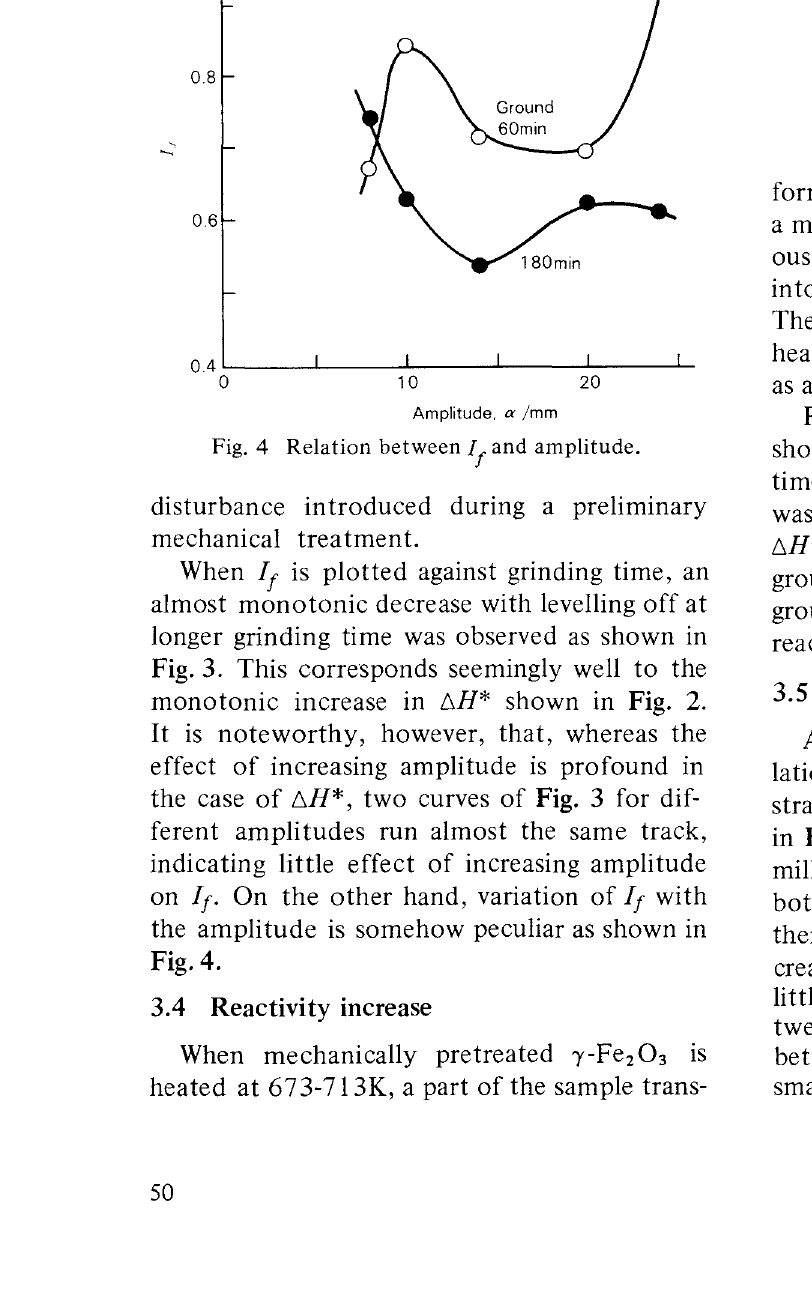
Fig. 5 Relation between a